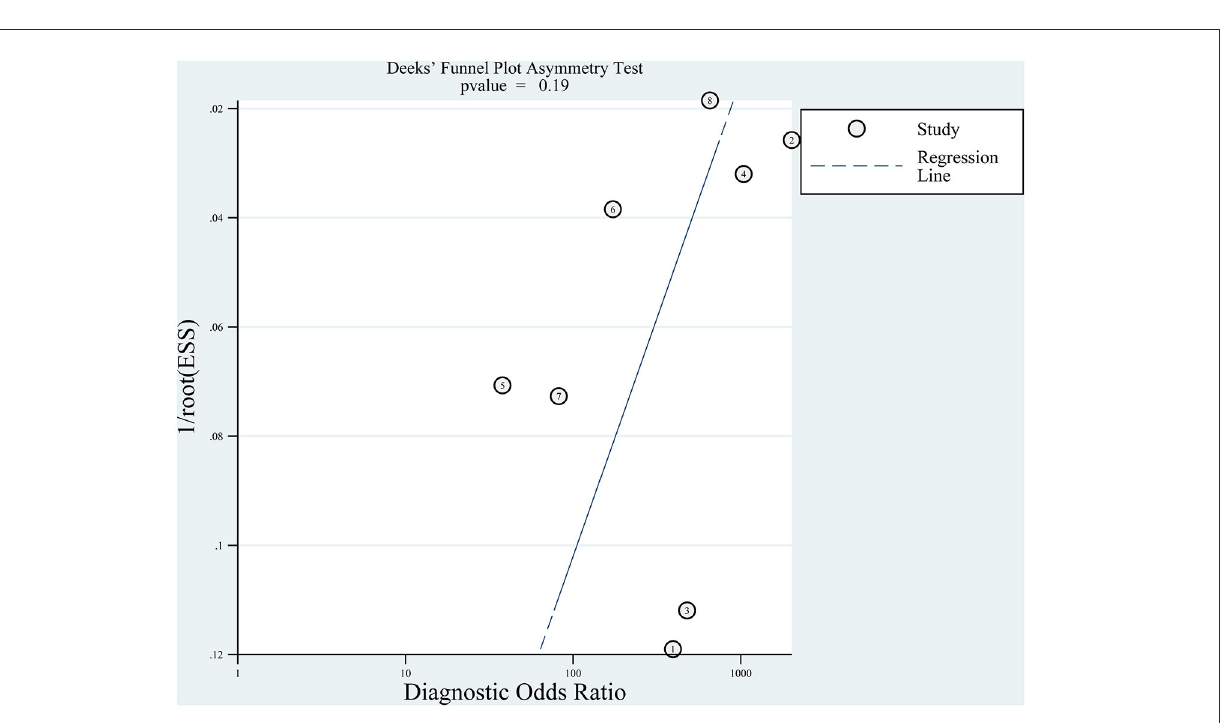
sensitivity and specificity of AI were significantly higher than those of